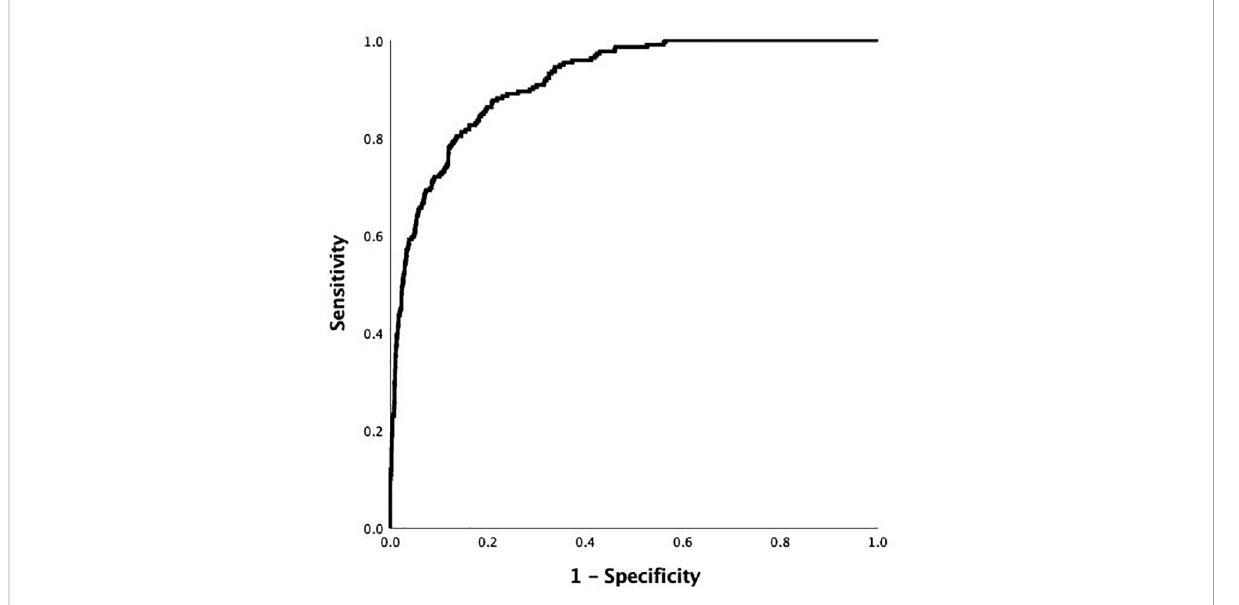
FIGURE 2 Receiver-operating characteristic (ROC) curve of the risk prediction model of DK in patients with T2DM in the development cohort. The AUC and its 95% CI were 0.917